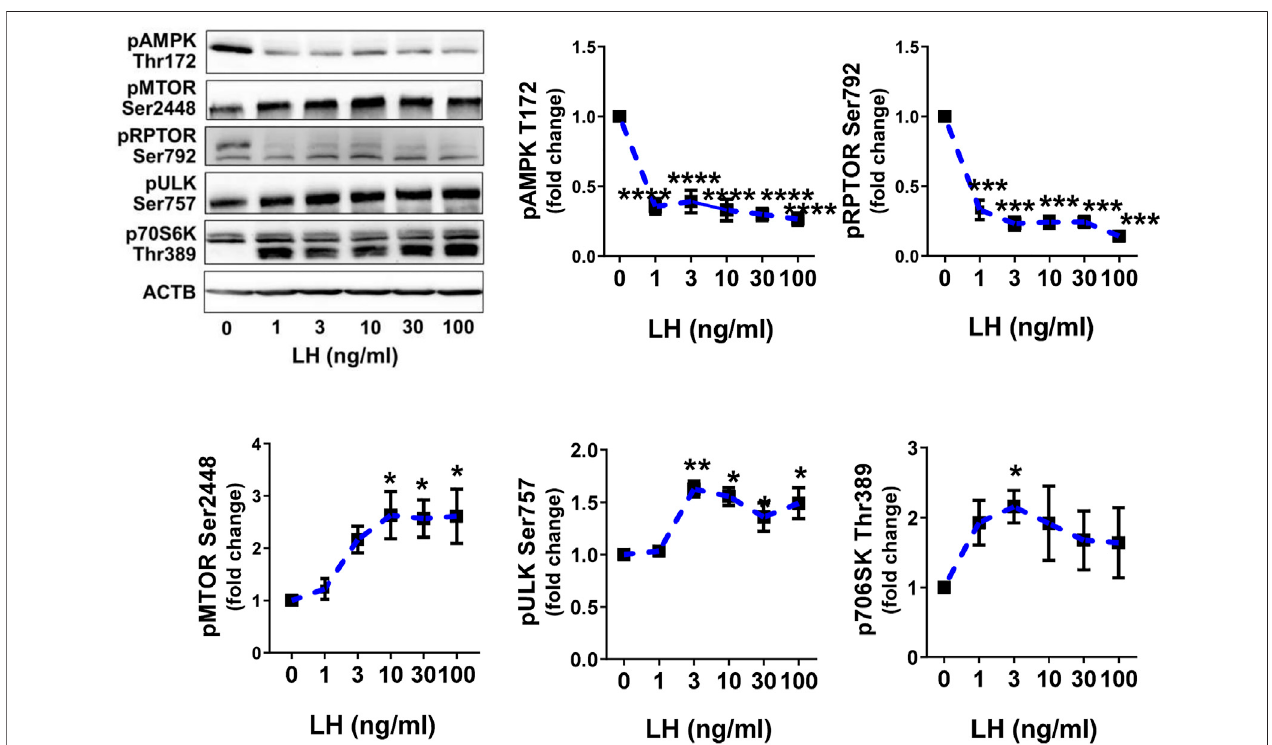
FIGURE 4 | LH inhibits AMPK activity and stimulates activity of MTOR. Primary cultures of small luteal cells were treated with increasing concentrations of LH (0 – 100 ng/ml) for 30 min. Line graphs and representative blots showing phosphorylation of AMPK α (Thr172), RPTOR (Ser792), MTOR (Ser2448), ULK1 (Ser757) and p70S6K(Thr389).Dataareshownastheaveragefoldchanges ± SEMfrom3to5separateexperiments.Datawerenormalizedto β -actin(ACTB).Statisticalanalysiswas performed using one-way ANOVA with post hoc Bonferroni tests. Signi fi cant differences between LH concentrations and control are indicated with asterisks *, **, ***, **** re fl ecting p < 0.05, p < 0.01, p < 0.001, p < 0.0001.